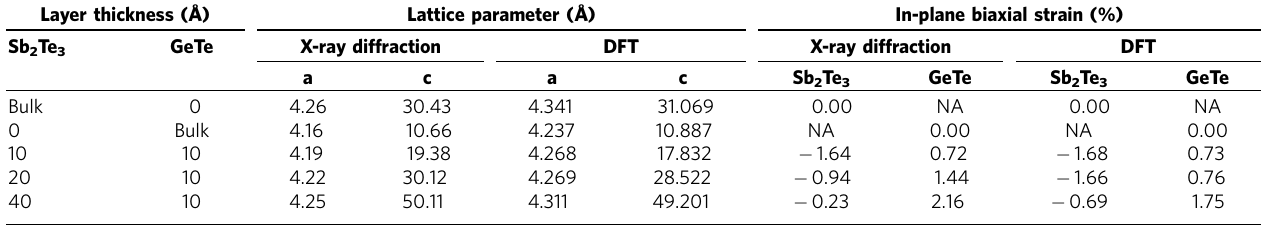
Table 1 | Superlattice lattice parameters.